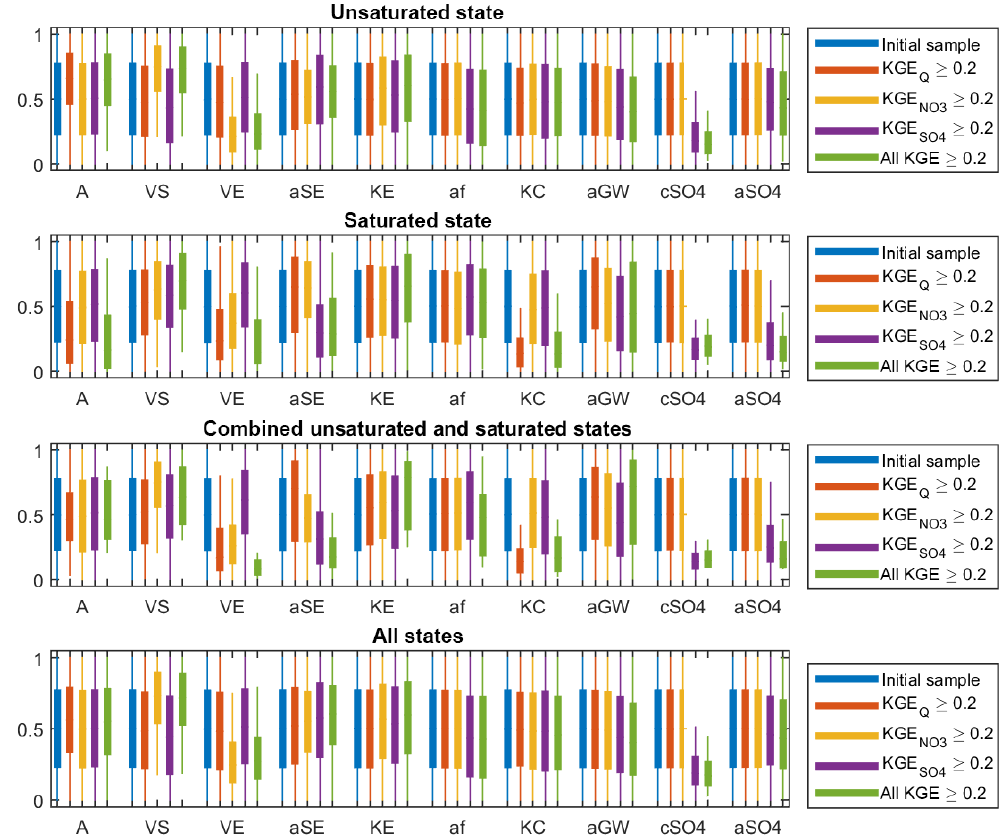
Figure 5. Distribution of model parameters (normalized by their ranges) after applying the four soft rules for the unsaturated, saturated, combined unsaturated and saturated, and all